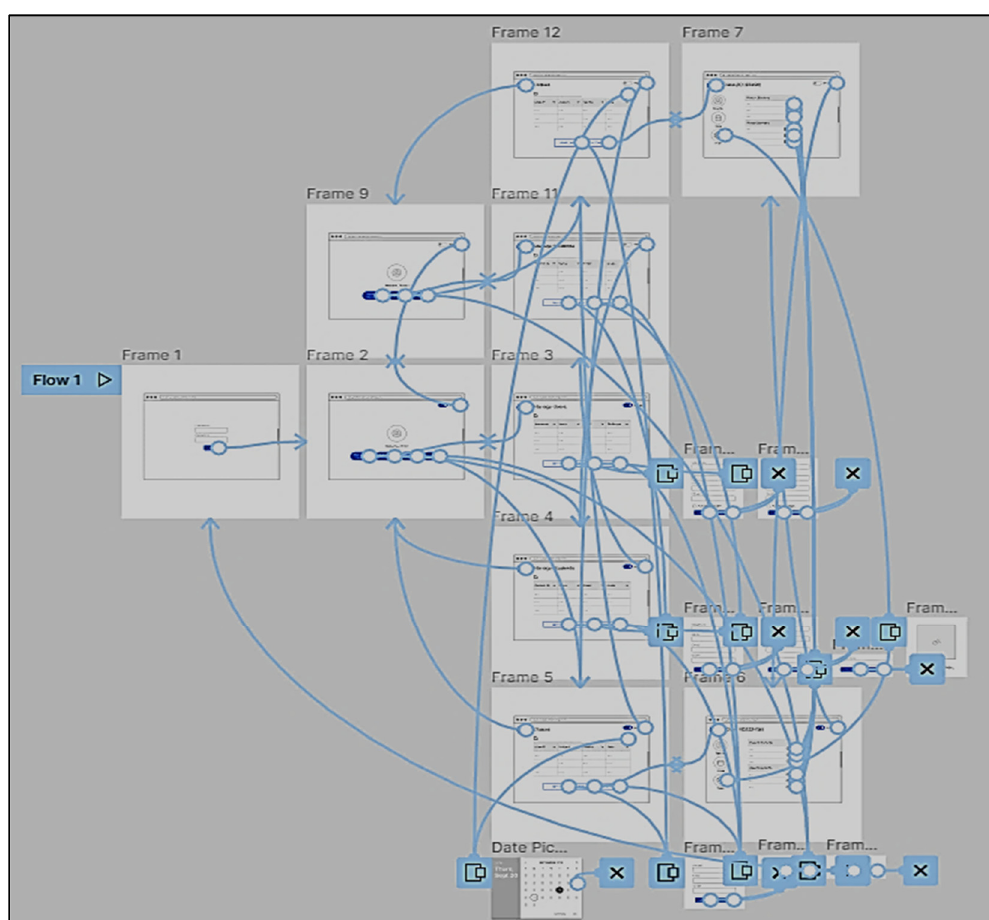
Figure 5. Prototype Interactions in Figma.